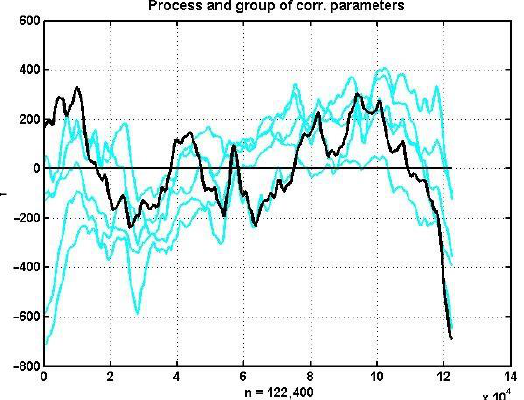
Figure 1. Two examples of observing the quotation of the EURUSD currency pair at two 10-day intervals with the system component identified by means of exponential filtering.